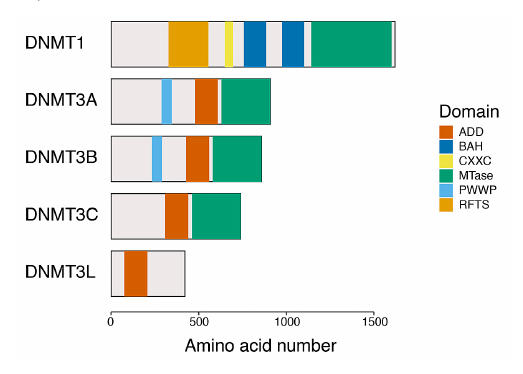
Figure 1: Domain structure of murine DNA methyltransferases. ADD = ATRX-DNMT3-DNMT3L; BAH = bromo-associated homolo- gy; MTase = methyltransferase; RFTS = replication foci targeting